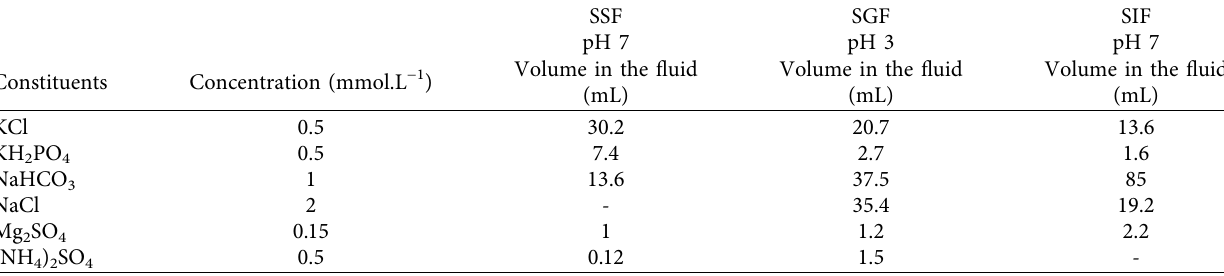
Table 1: Composition of simulated digestive fuids.